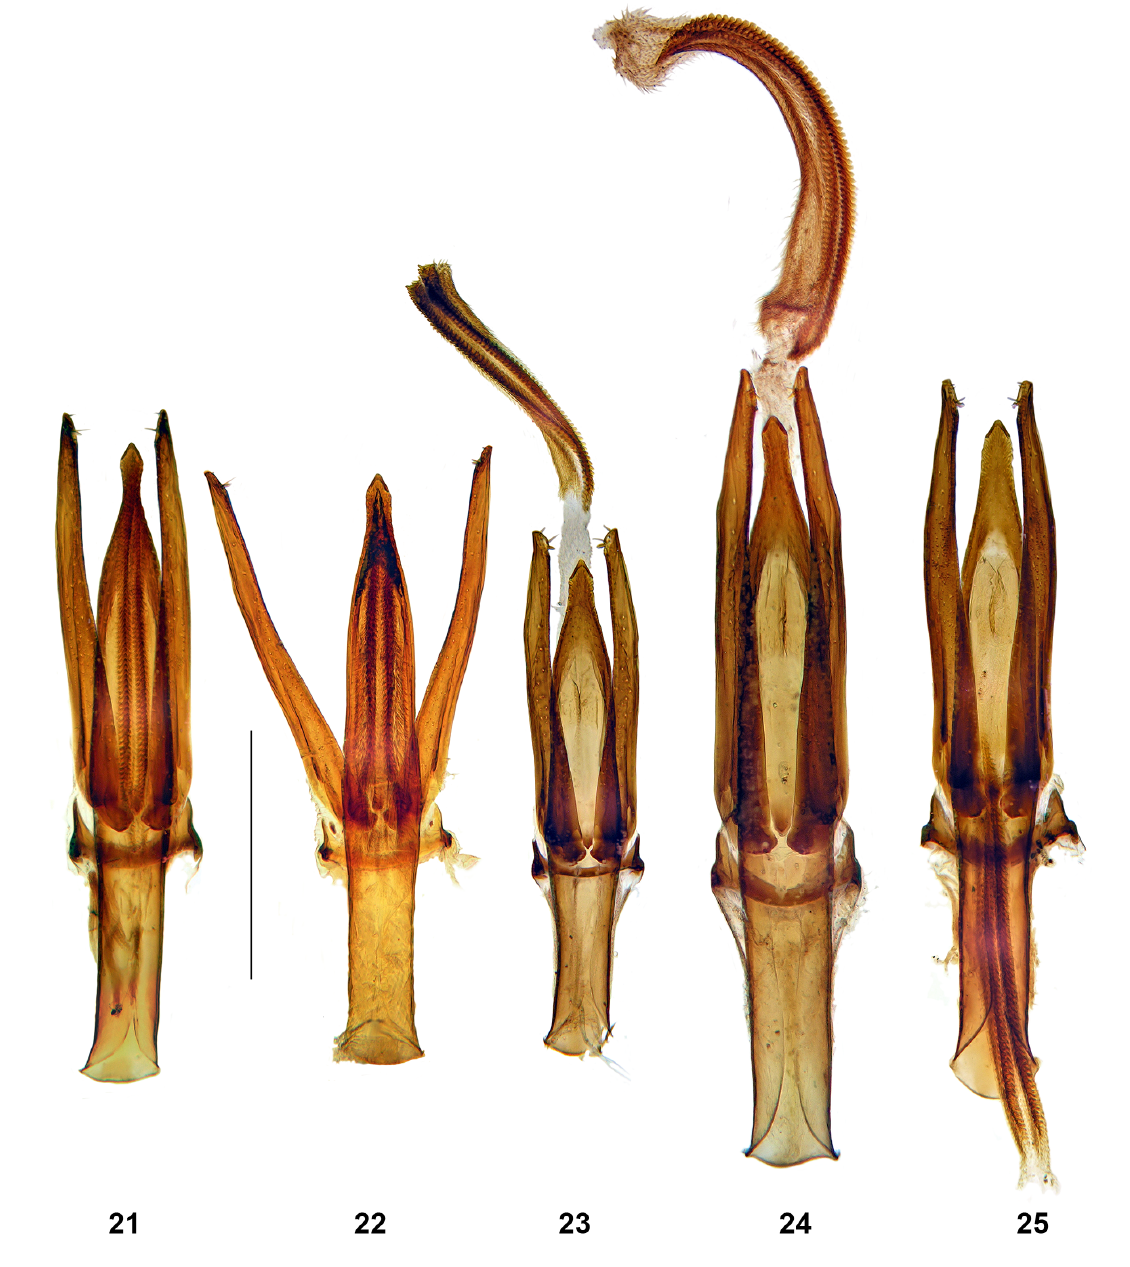
Figs 21–25. Speonemadus of the escalerai -group, aedeagus. 21 . Paratype of S. algarvensis sp. nov. (Gruta do Vale Telheiro). 22 . S. angusticollis (Kraatz, 1870) (Rute). 23 . S. bolivari (Jeannel, 1922) (Ardales). 24 . S. breuili (Jeannel, 1922) (Motillas). 25 . S. escalerai (Uhagón, 1898) (Jumilla). Scale bar = 0.5